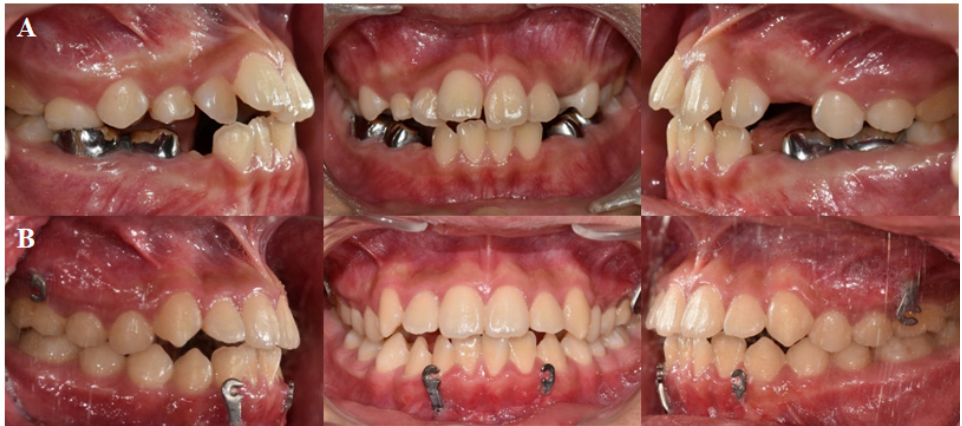
Figure 2. ( A ) Initial intraoral photographs. ( B ) Intraoral photographs 24 months after customized bone anchored maxillary protraction therapy showing Class I molar key.